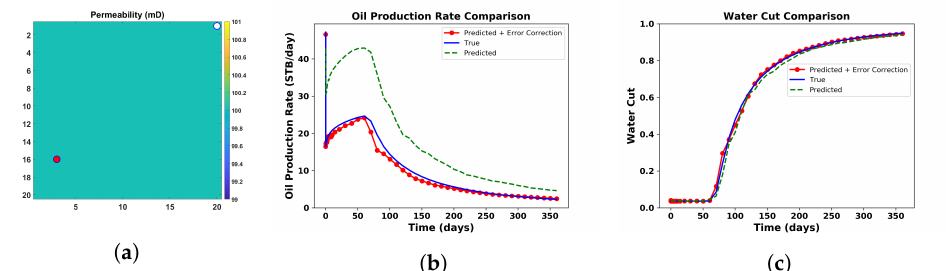
Figure 27. ( a ) Test case with producer well location at (3,16). ( b ) aomparison of oil production rate and ( c ) comparison of water cut, predicted using the global PMOR method alone using 50 samples (dotted green line) and after the implementation of error correction model (red circled line) with the true solution (blue line).